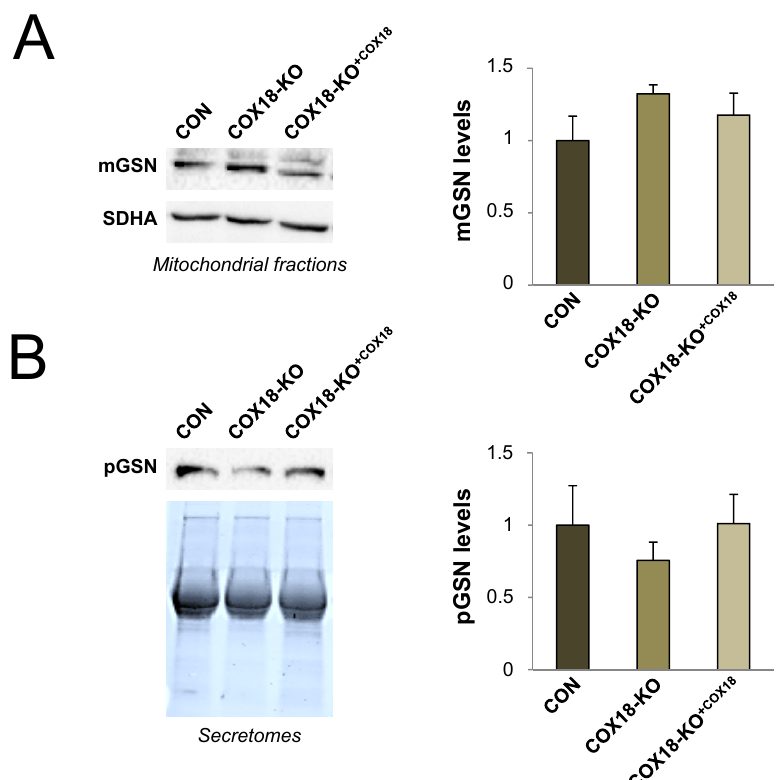
Figure 4. Modulation of the mGSN:pGSN ratio by genetic manipulation of OXPHOS deficiency. Control HEK293T cells (CON, n = 3), and mutant cells depleted of COX18 (COX18-KO, n = 2) and subsequently rescued by stable overexpression of wild-type COX18 (COX18-KO + COX18 , n = 3) were harvested at 90% confluence. ( A ) In total, 40 µ g of mitochondrial protein extracts were separated on 10% SDS-PAGE gels. mGSN levels were analyzed by immunoblotting, using SDHA as the loading control. ( B ) In total, 50 µ g of secreted protein extracts were separated on 4–20% TGXTM Precast Protein Gels (Biorad). pGSN levels were analyzed by immunoblotting and normalized by the total protein amount per lane. Experimental data are presented as the mean ± SD relative to control values, set as 1. mGSN, mitochondrial GSN; pGSN, plasma